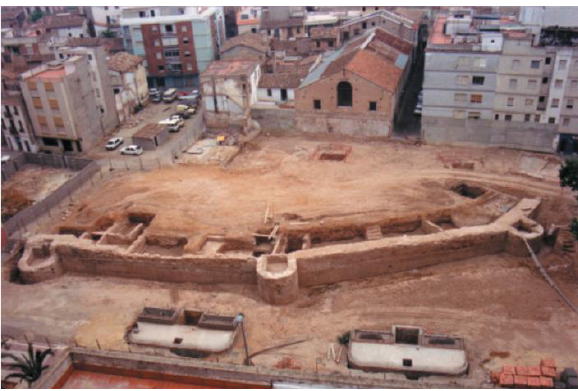
Figure 4. Archaeological excavation of the wall.